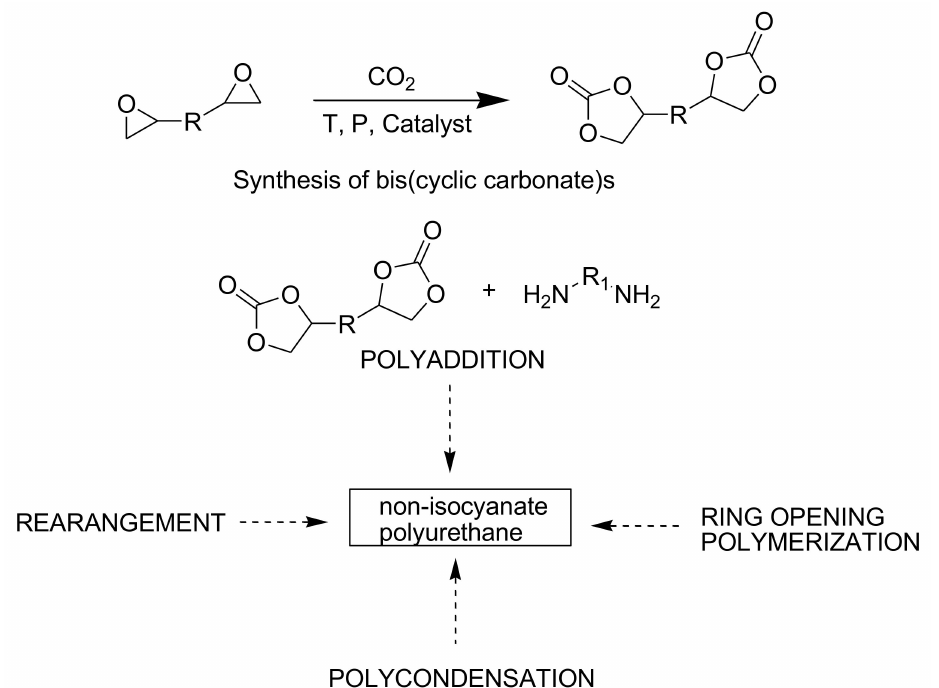
Figure 3. Possible pathways for synthesis of NIPUs